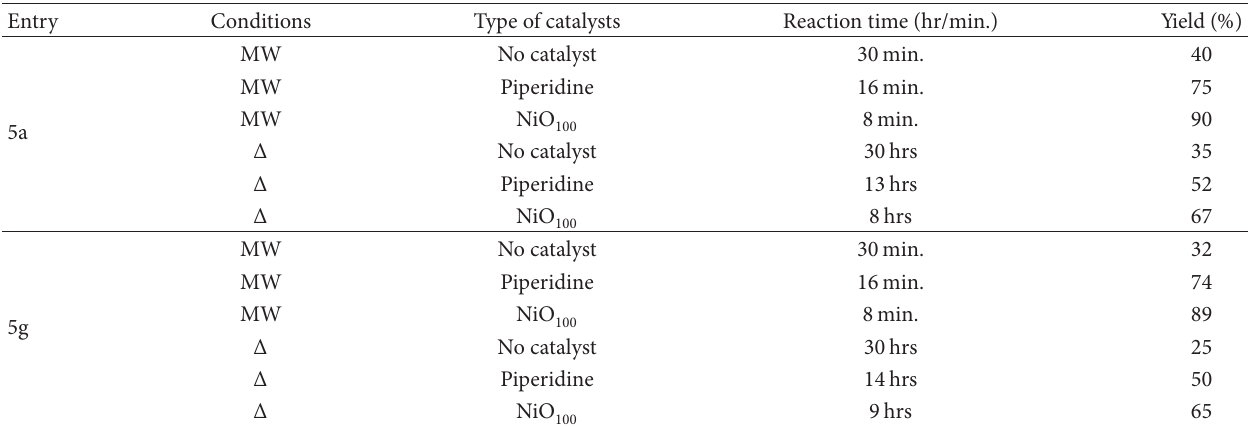
T 2: Comparison of catalytic activity of NiO and microwave irradiation methods.